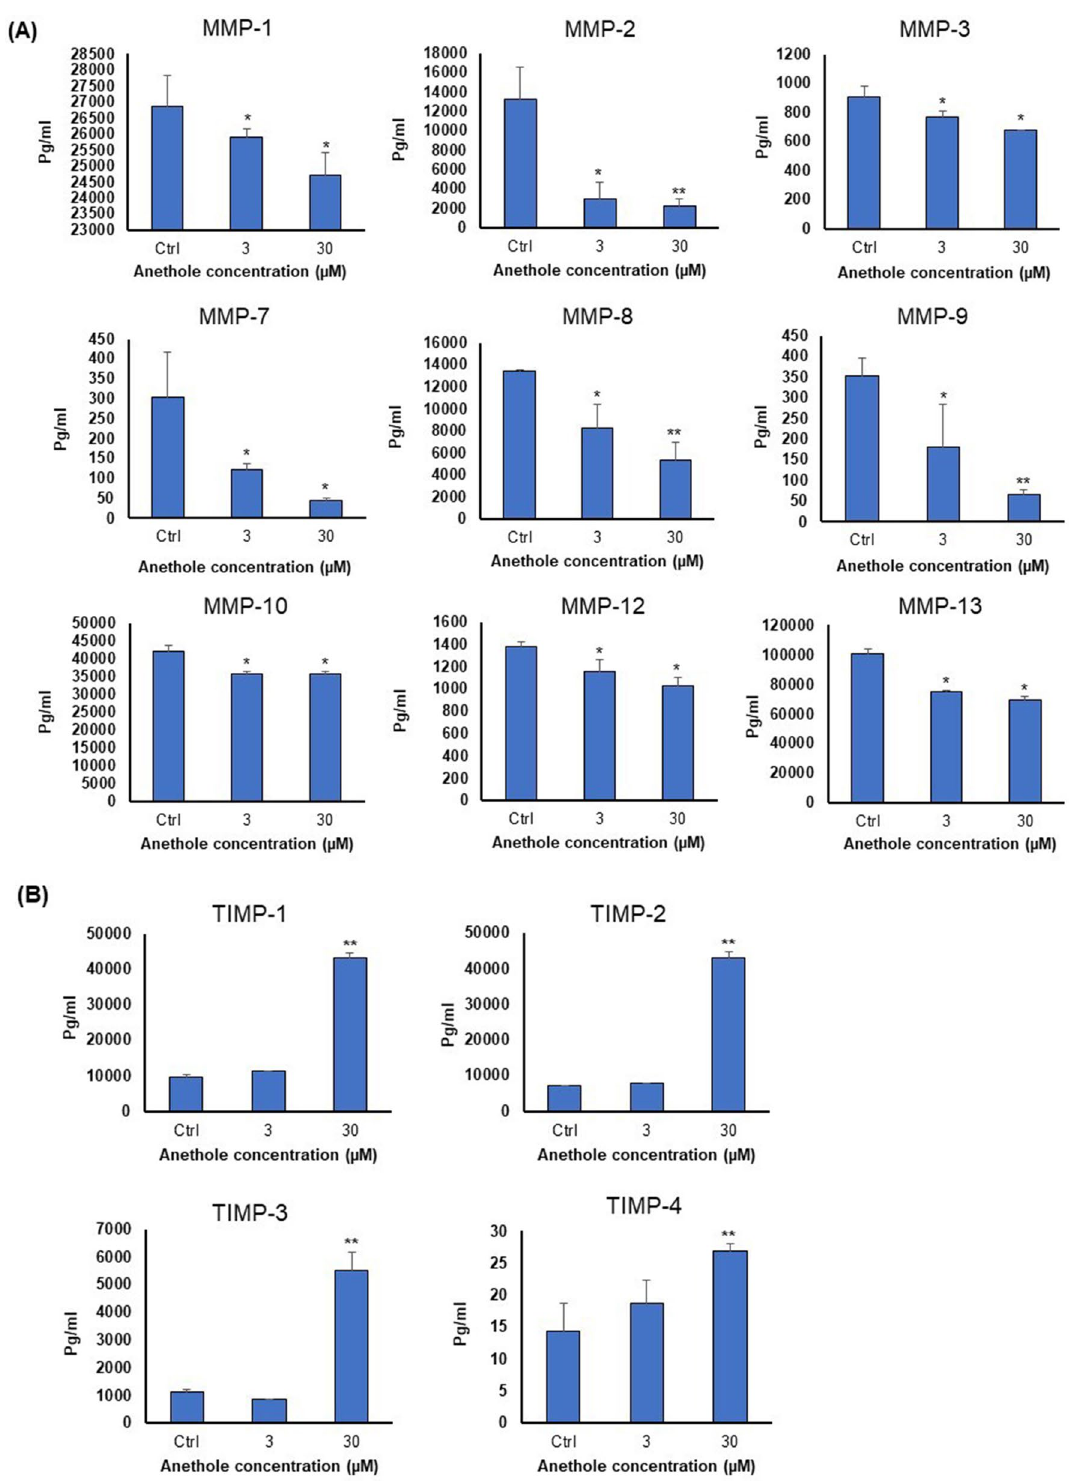
Figure 7. Anethole reduce the MMPs expression and increase TIMPs expression of oral cancer cells. Mouth epidermoid carcinoma cells (Ca9-22) were maintained in culture with or without anethole for 24 h. The Luminex xMAP technology for multiplexed quantification was used to measure the 9-plex of MMP and the 4-plex of TIMP. The analysis was performed using the Luminex 100 system (n = 3). ( A ) Anethole 3 μM and 30 μM significantly decreased the MMPs (− 1, − 2, − 3, − 7, − 8, − 9, − 10, − 12, and − 13) expression, compared to control. ( B ) Anethole 30 μM significantly increased TIMPs (− 1, − 2, − 3 and − 4) expression, compared to control. Significance was obtained when comparing the control to anethole treated cells. * p < 0.05 or ** p <